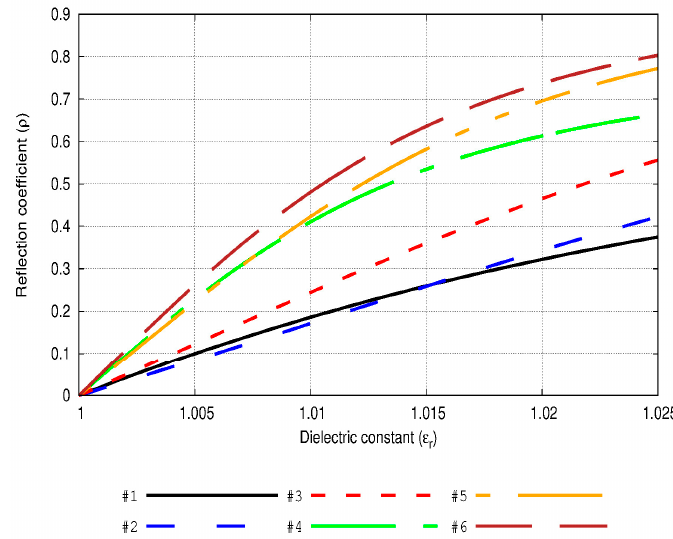
Figure 6. Behavior of the reflection coe ffi cient for each simulated antenna as the enclosing medium is changed. The line number corresponds to the antenna number of Table 2. Antenna #6 shows the highest slope and reaches a value of 0.47 for the reflection coe ffi cient when ε r = 1.01.